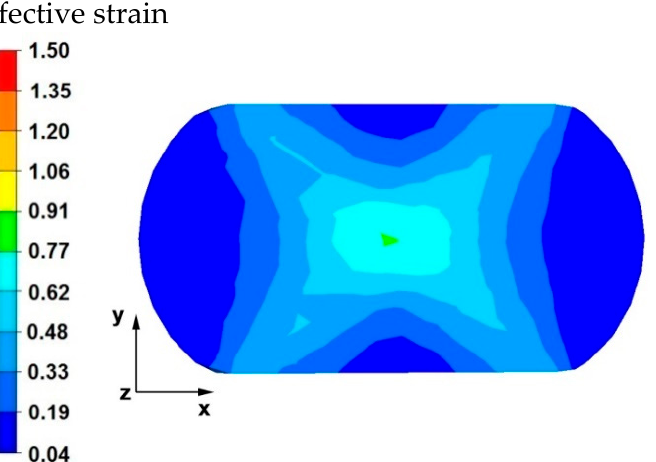
Figure 4. Distribution of the effective strain value on the surface of the cross-section of the sample without the modeled discontinuity after deformation with 35% reduction .